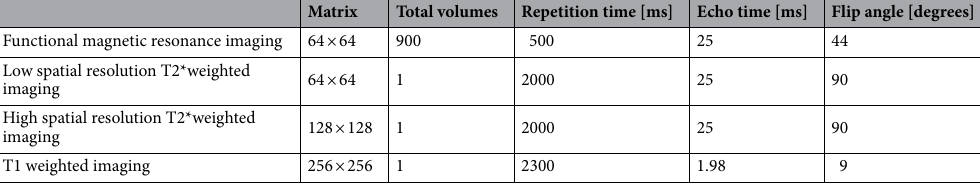
Table 1. Magnetic resonance imaging scan